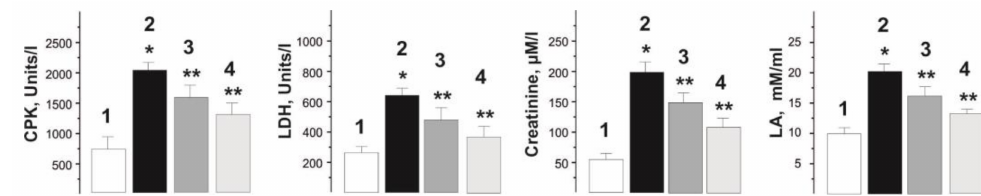
Figure 5. Biochemical parameters of rat blood (CPK, LDH, creatinine and LA) after chronic glyphosate intoxication for 30 days. 1—control group (native muscle); 2—the glyphosate group; 3—the glyphosate+C 60 fullerene (0.5 mg/kg) group; 4—the glyphosate+C 60 fullerene (1 mg/kg) group; * p < 0.05 relative to the control group; ** p < 0.05 relative to the glyphosate